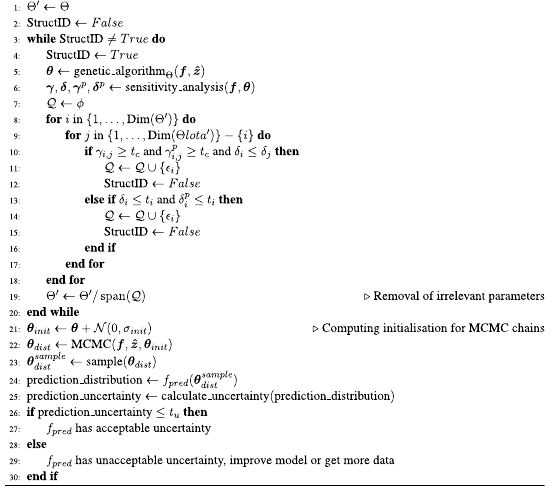
Algorithm 1. Automatic Calibration Algorithm.